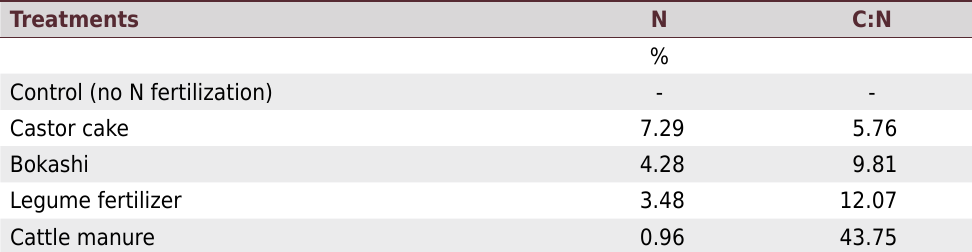
Table 1. Nitrogen content and C:N ratio of organic N fertilizers Treatments N C:N % Control (no N fertilization) - - Castor cake 7.29 5.76 Bokashi 4.28 9.81 Legume fertilizer 3.48 12.07 Cattle manure 0.96 43.75 - = without N-fertilization; N = total nitrogen, determined by the Kjeldahl method; C = organic carbon, determined by the Walkley – Black method (Claessen,